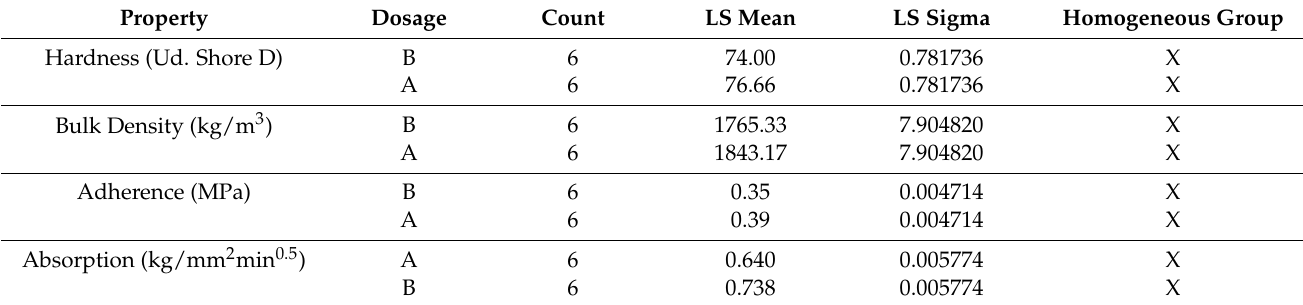
Table 12. Multiple range test for complementary tests considering the cement/aggregate ratio.